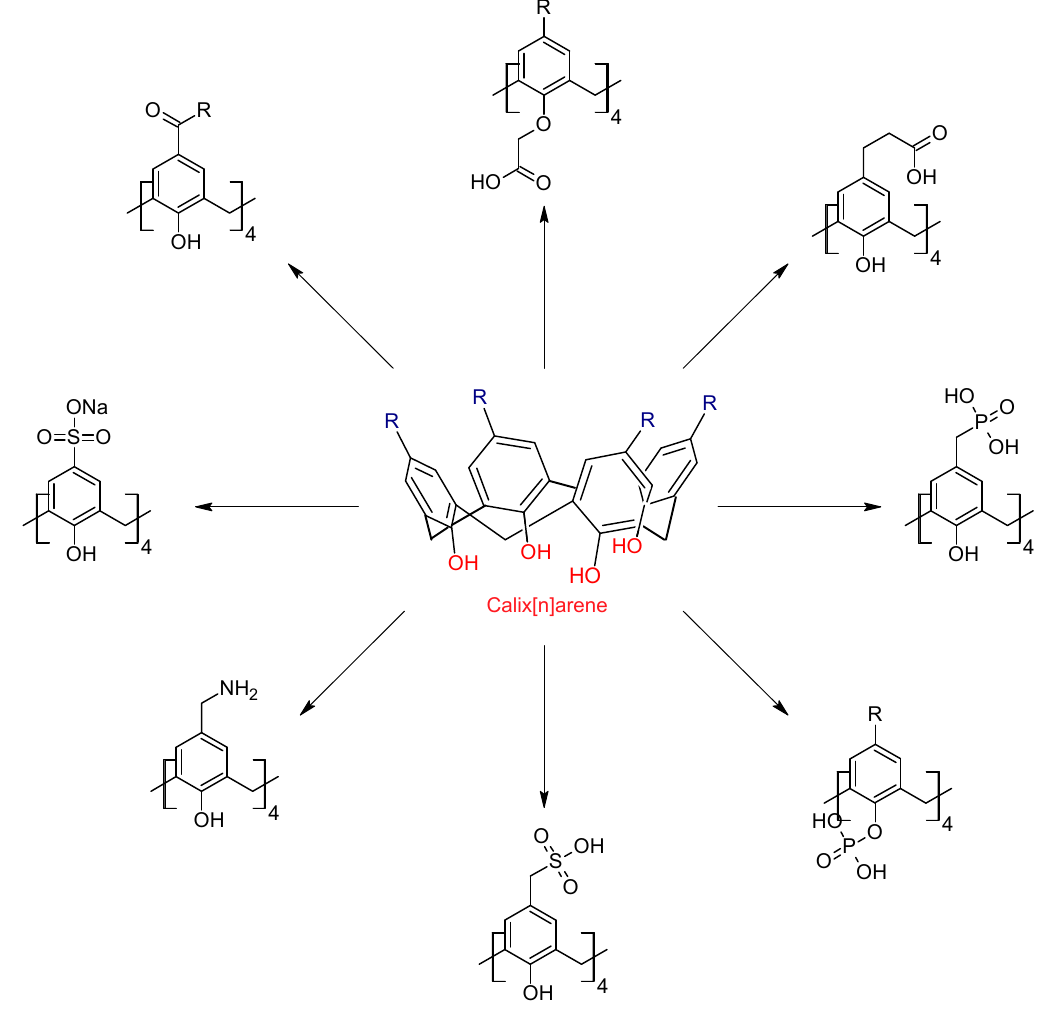
Figure 4. Polar derivatives of calixarenes.